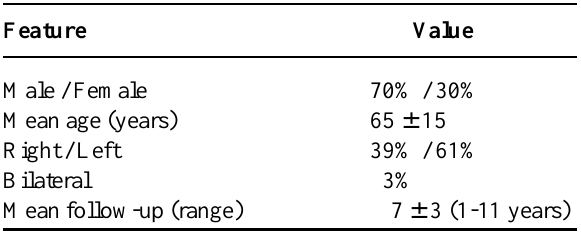
Table 1 – Clinical features of upper urinary tract urothelial